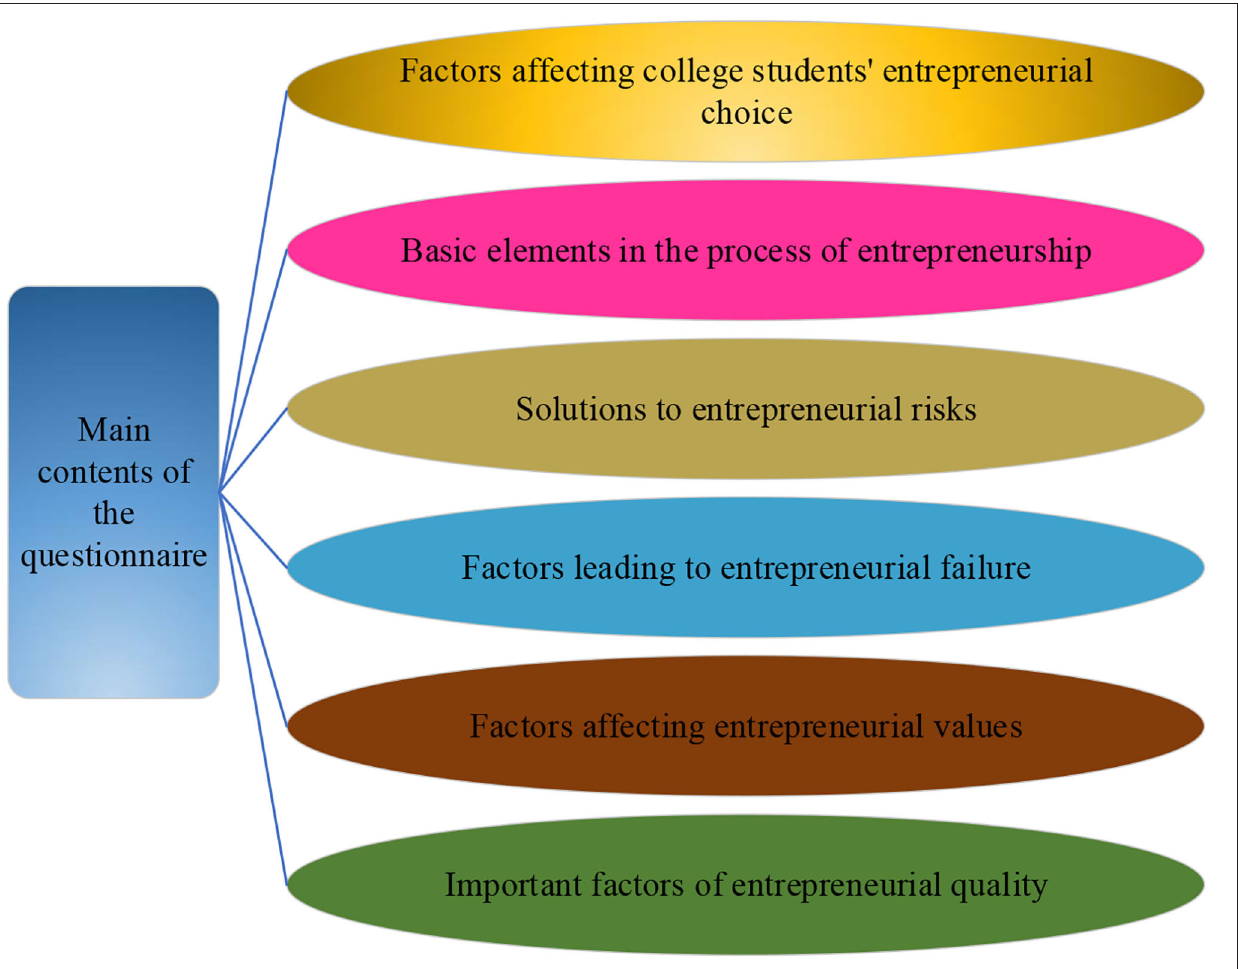
FIGURE 8 | The specific content of the